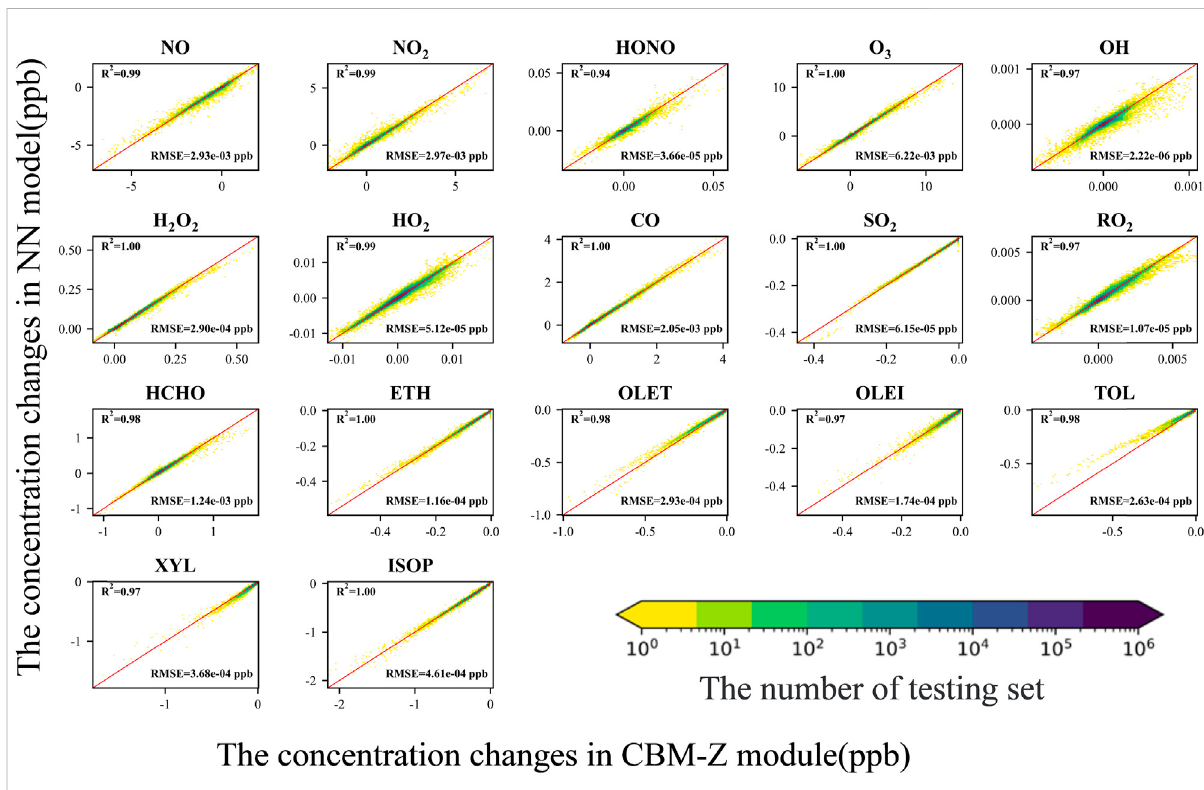
FIGURE 2 Densityscatterdiagramof17keyphotochemicalspeciesconcentrationchangespredictedbytheneuralnetworkemulator( y -axis)andthetrue valuesimulatedbytheCBM-ZmoduleinGNAQPMS( x -axis).Thecolorofthescatterrepresentsthenumberofthetestingdata.Theredsolidlinesare the 1:1